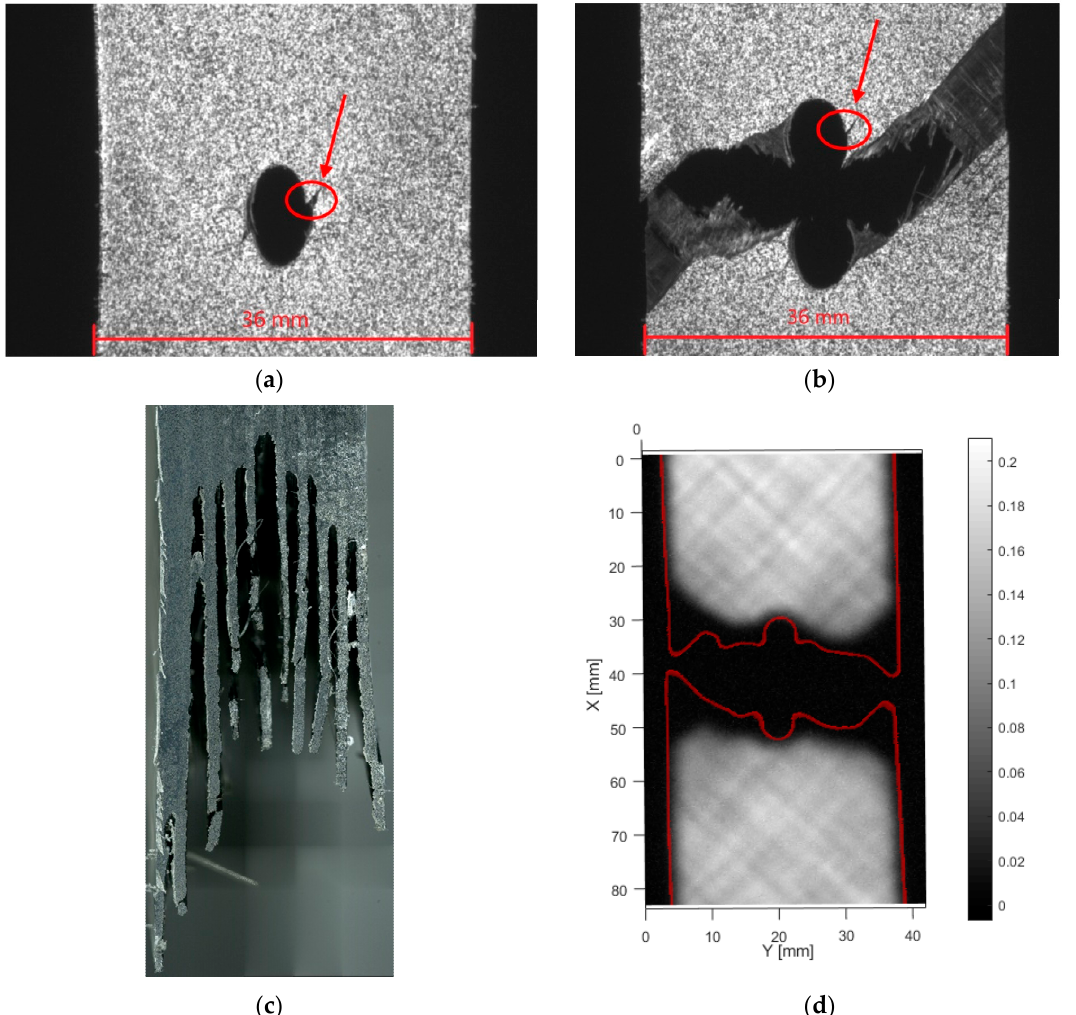
Figure 6. Compressive failure of [0/90] 5s . ( a ) front view just before failure, ( b ) front view after kinking failure, ( c ) side microscopy, ( d ) through transmission ultrasound (for high resolution, please refer to the online version of this article).